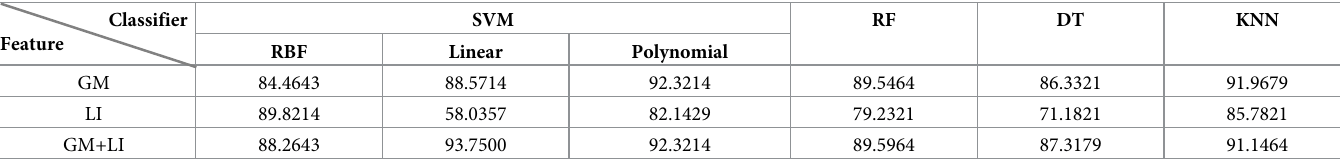
Table 5. Classification results in LMCI versus AD under three kinds of